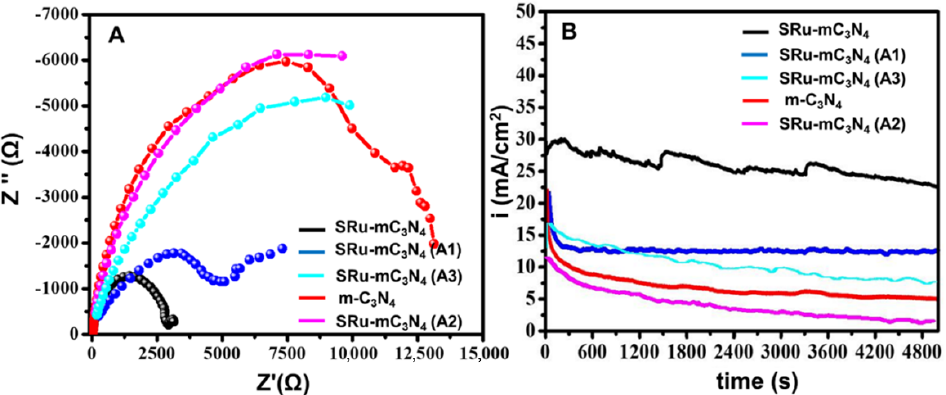
Figure 4. ( A ) Electrochemical impedance spectroscopic (EIS) measurements: SRu-mC 3 N 4 (A2), m-C 3 N 4 , SRu-mC 3 N 4 (A3), SRu-mC 3 N 4 (A1), and SRu-mC 3 N 4 in 6 μM N 2 H 4 + 0.5 M KOH for an AC frequency range of 10–1000 Hz. ( B ) Chronoamperometric studies of m-C 3 N 4 (I) and SRu-mC 3 N 4 (II) in 6 μM N 2 H 4 + 0.5 M KOH at an applied potential of 1.3 V vs. RHE (based on obtained current density of 20 mA/cm 2